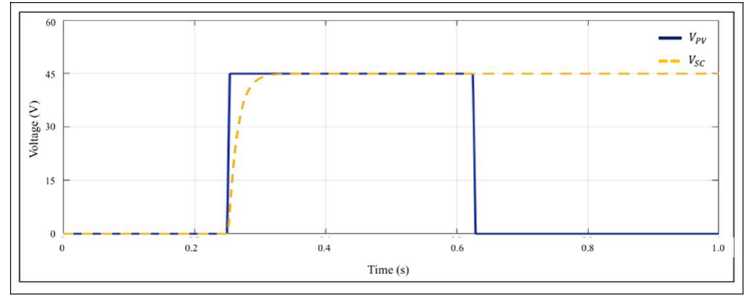
Figure 6. Transitory response test. photovoltaic (PV) array voltage ( V PV ); and supercapacitor (SC) voltage ( V SC